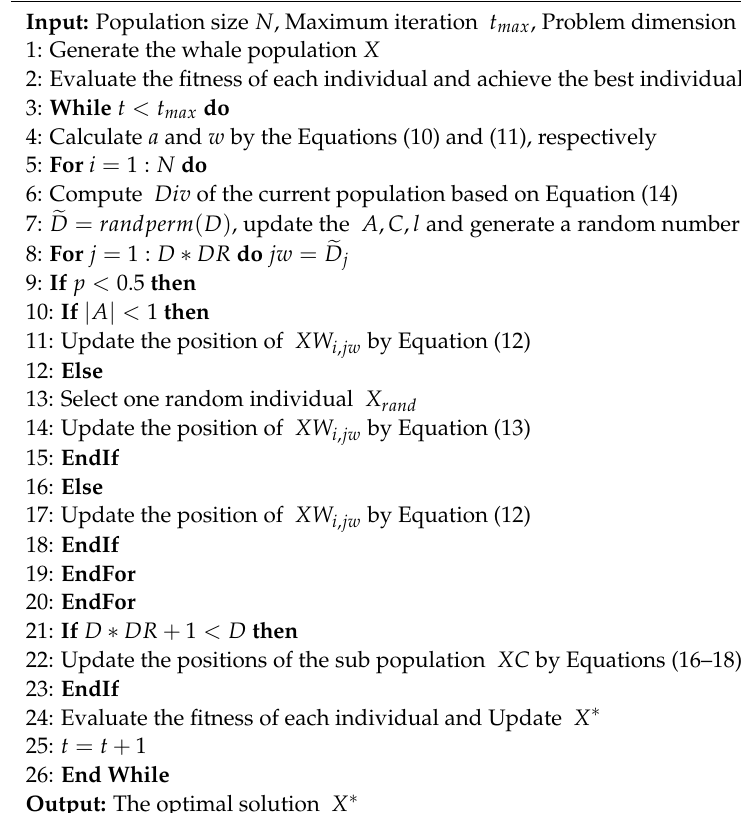
Algorithm 1: The description of MWOA-CS